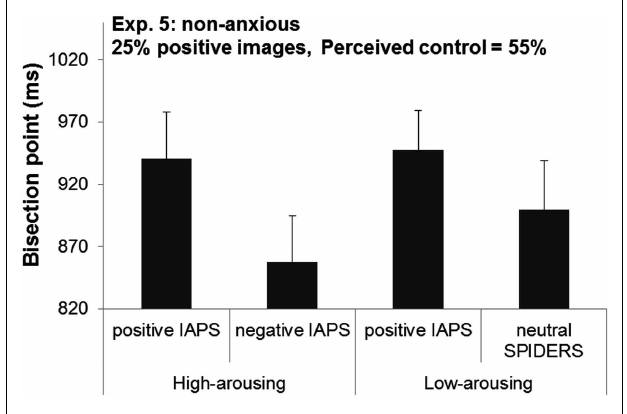
FIGURE 3 | Bisection points in Experiment 5 as a function of the emotional content of the image events.